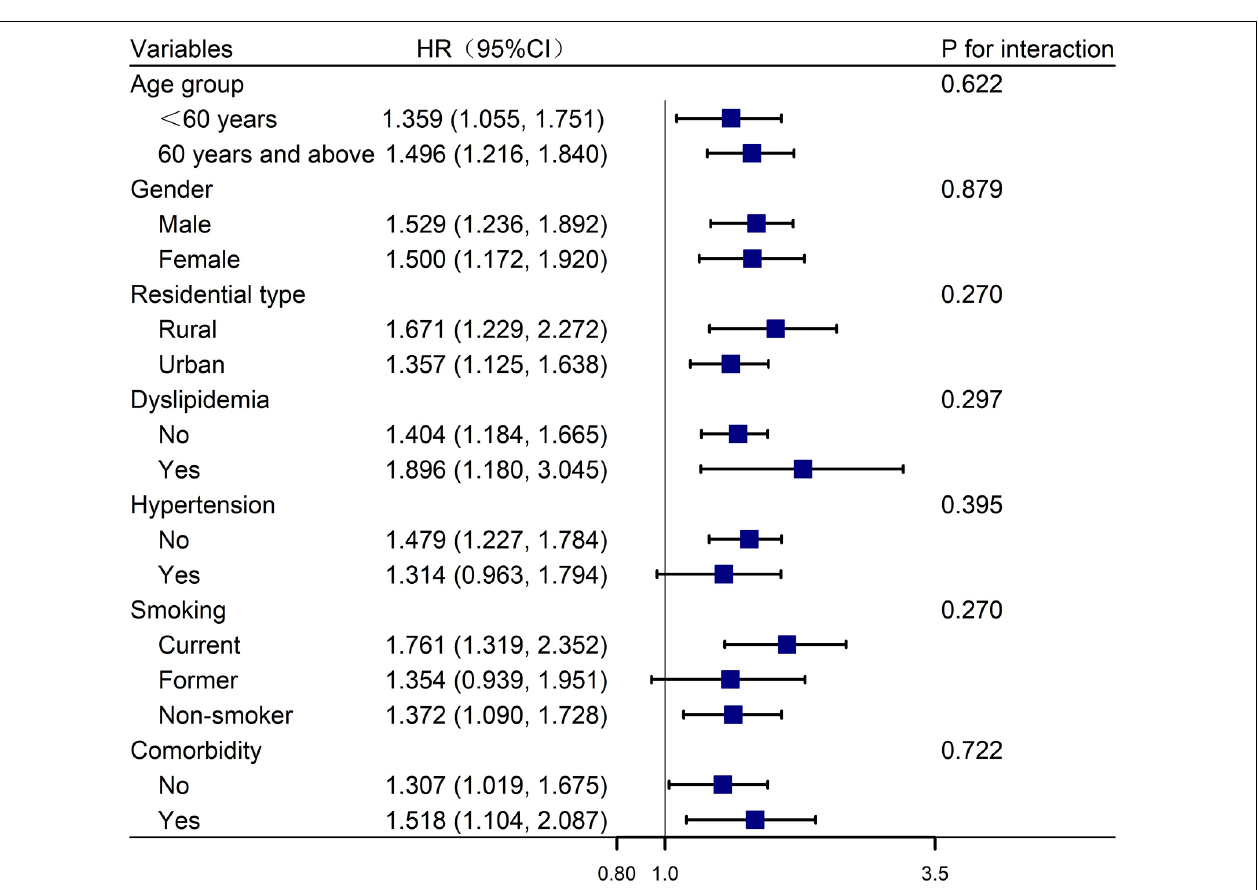
FIGURE 2 | Forest plot of the relationship between baseline CLD status and depressive symptoms incidence. The blue square represents the HR value, and the line across the blue square represents the 95% confidence